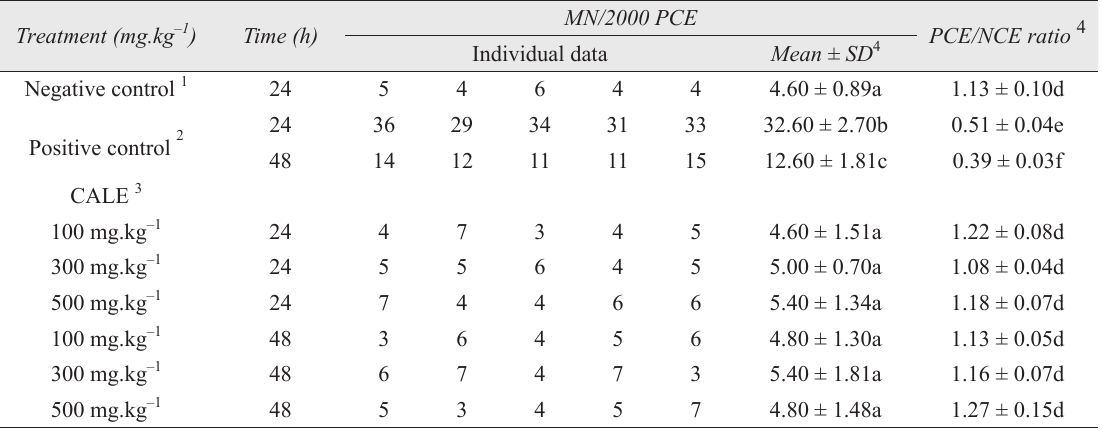
MNPCE frequencies and PCE/NCE ratio in mouse bone marrow cells treated with Celtis iguanaea aqueous extract (CALE) at different doses and